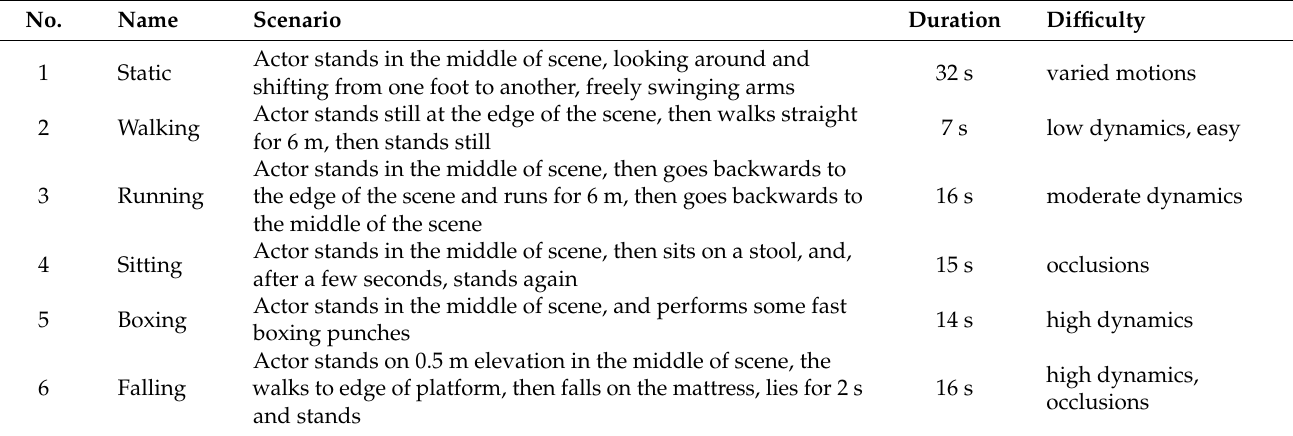
Table 1. List of mocap sequence scenarios used for the